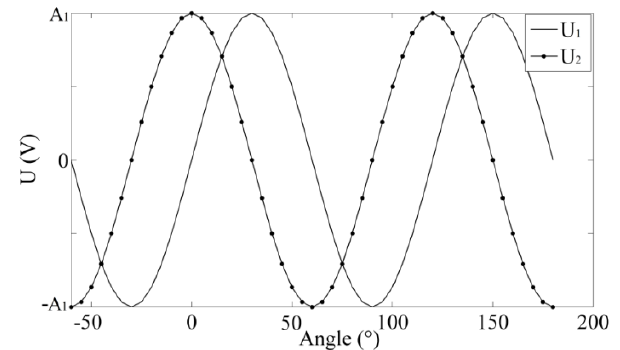
Figure 2. Induced voltages in two receiving coils.